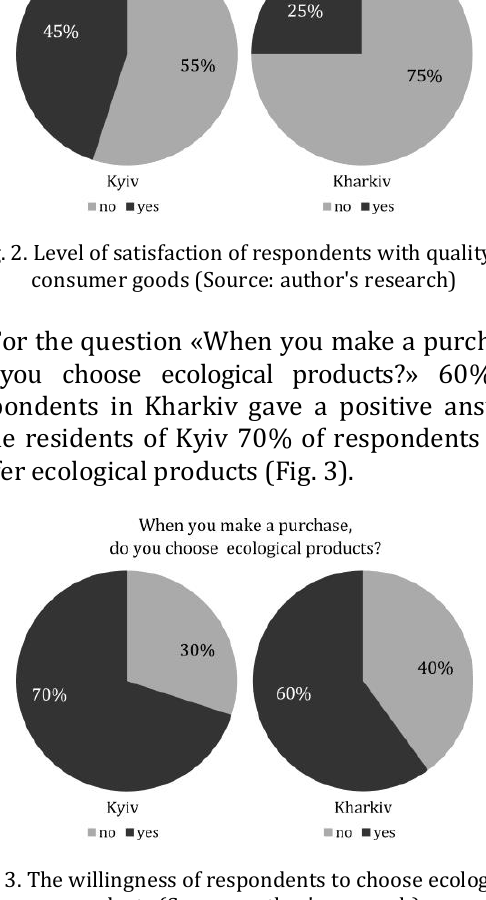
Fig. 3. The willingness of respondents to choose ecological products (Source: author's